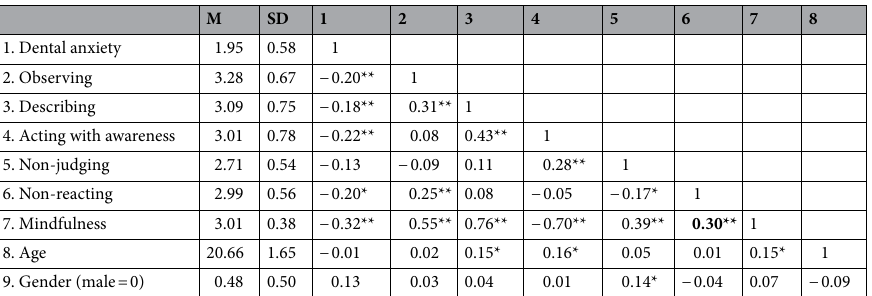
Table 1. Descriptive statistics and correlations between primary variables (study 1). *p < 0.05, **p < 0.01, n = 206. Significant values are in bold.